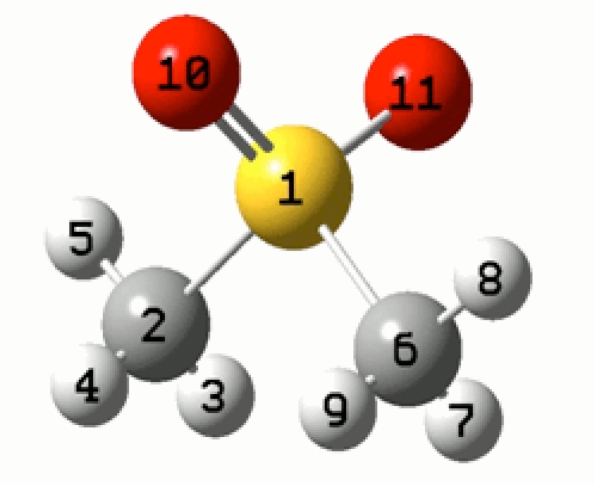
Methylsulfanomethane (MSM) [(CH3)2SO2] molecule. The Ball 1 is S, balls 10 and 11 are 16O, and the balls 2 and 6 are 12C and the remaining balls are 1H.